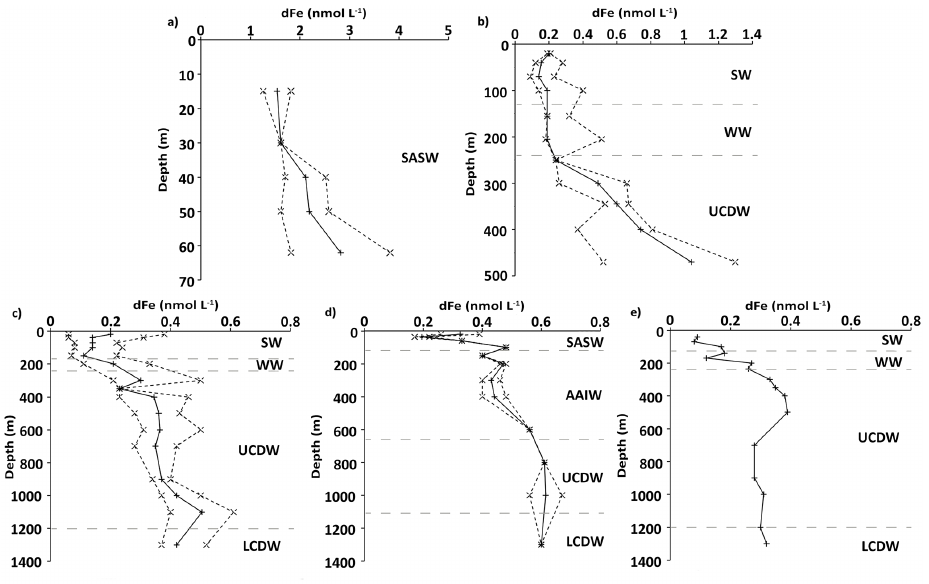
Figure 4. Vertical distribution of dFe concentrations measured in clusters 1 (a) , 2 (b) , 3 (c) , 4 (d) , and 5 (e) showing the median dFe (solid line with crosses). The interquartile range, defined as the range around the median containing 50% of the data, is given between the two dotted